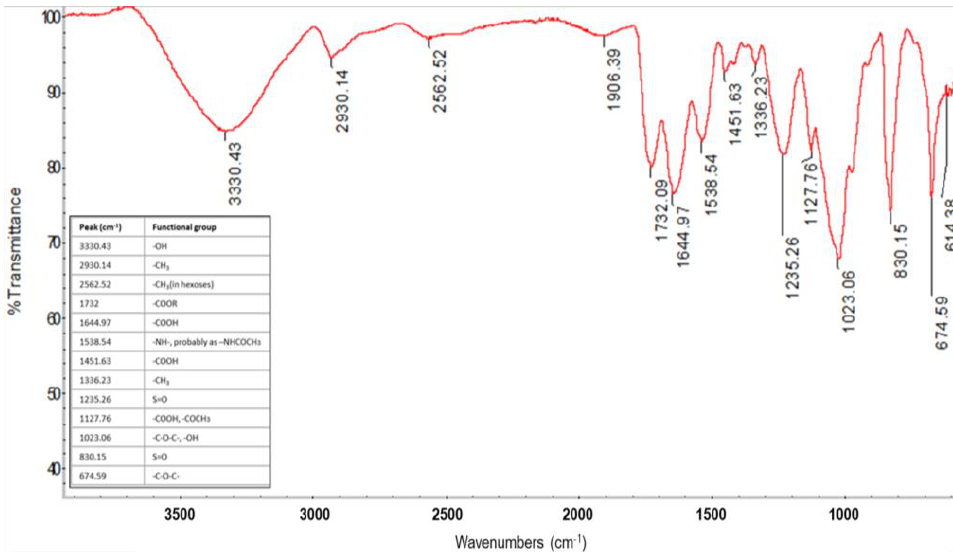
Figure 5. FTIR spectrum of the EPS produced by the BU-4 isolate in glucose-based medium. The inner table gives the peak assignment.